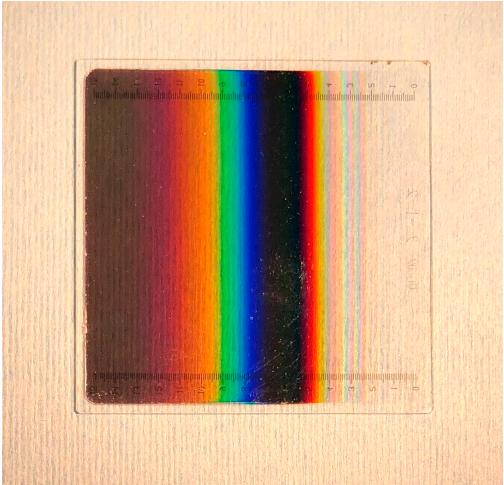
Figure 7. Sample photograph of the developed LVF.